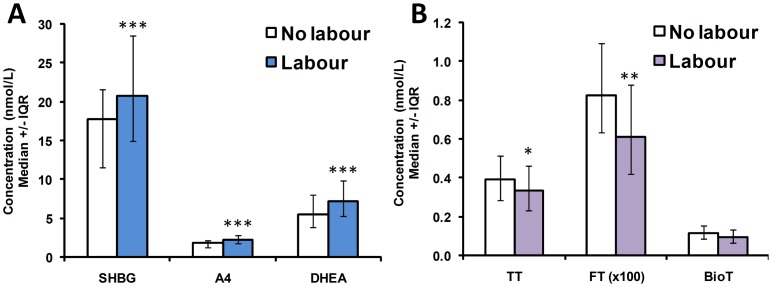
Effects of labor on androgen and SHBG concentrations.A) SHBG, A4 and DHEA concentrations are significantly increased with labor (n = 83 no labor, 718 with labor); B) TT and FT, but not BioT, levels are significantly reduced with labor. Data shown are median ± interquartile range (IQR). Note that the FT values have been multiplied by 100 to allow presentation on the same graph. *, P<0.05; **, P<0.01; ***, P<0.0005 by Kruskal Wallis test.